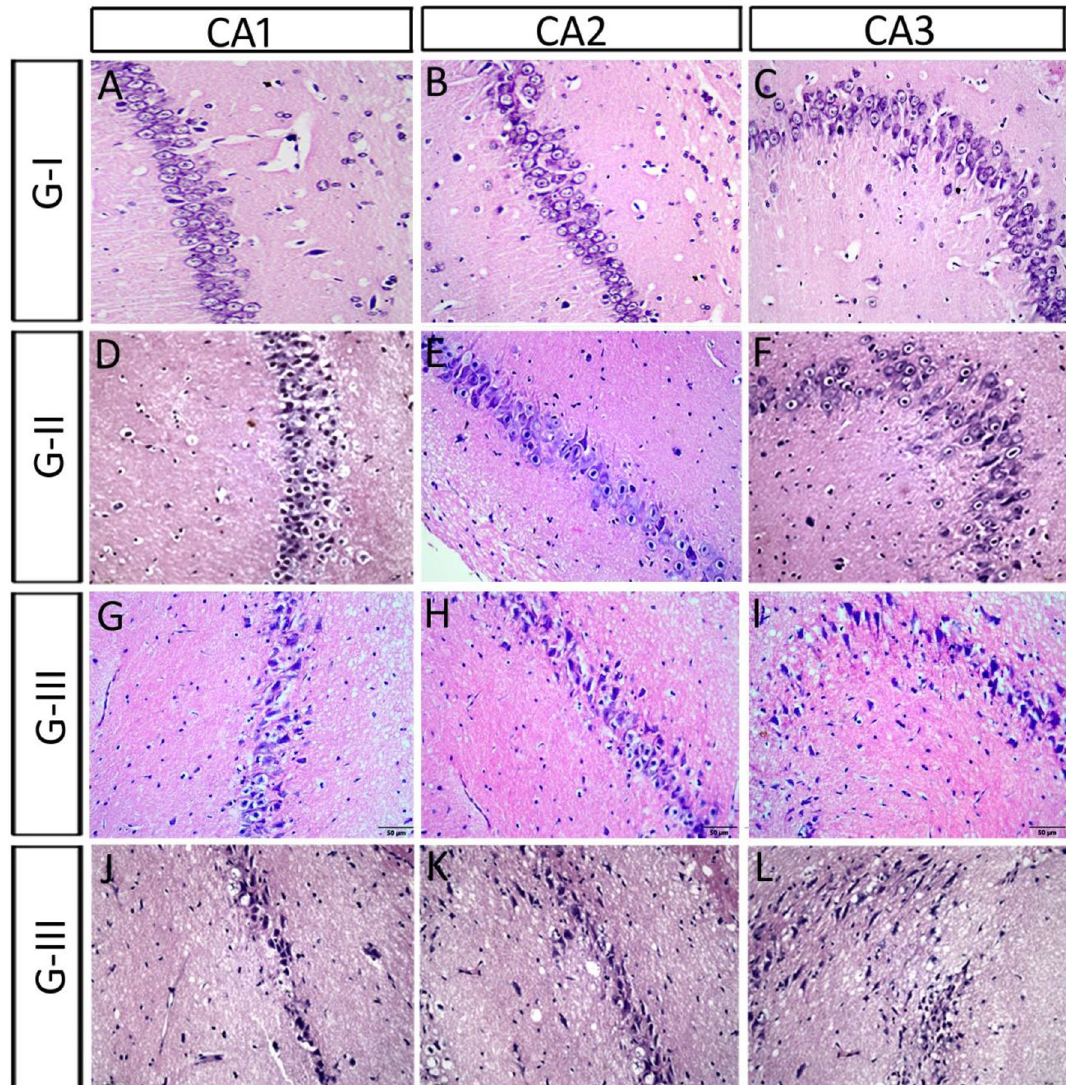
Figure 3. showing the microscopic features of scopolamine administrated groups: ( A – C ) the pyramidal layers of the control group I. ( D – F ) In group II there were signs of mild neurodegeneration, such as, Balloon cells (BC) with a remnant of the cytoplasm encircling the balloon. ( G – I ) In group III, there were more signs of neurotoxicity after the ES, for example complete ballooning of the entire cells (balloon achromatic cells) in all hippocampal subfields. ( J – L ) One rat of the ES group (III) showed a highly deformed hippocampus. CA1-CA2 pyramidal cells had been deformed with dysmorphic shapes and CA3 disappeared and few vacuoles were seen